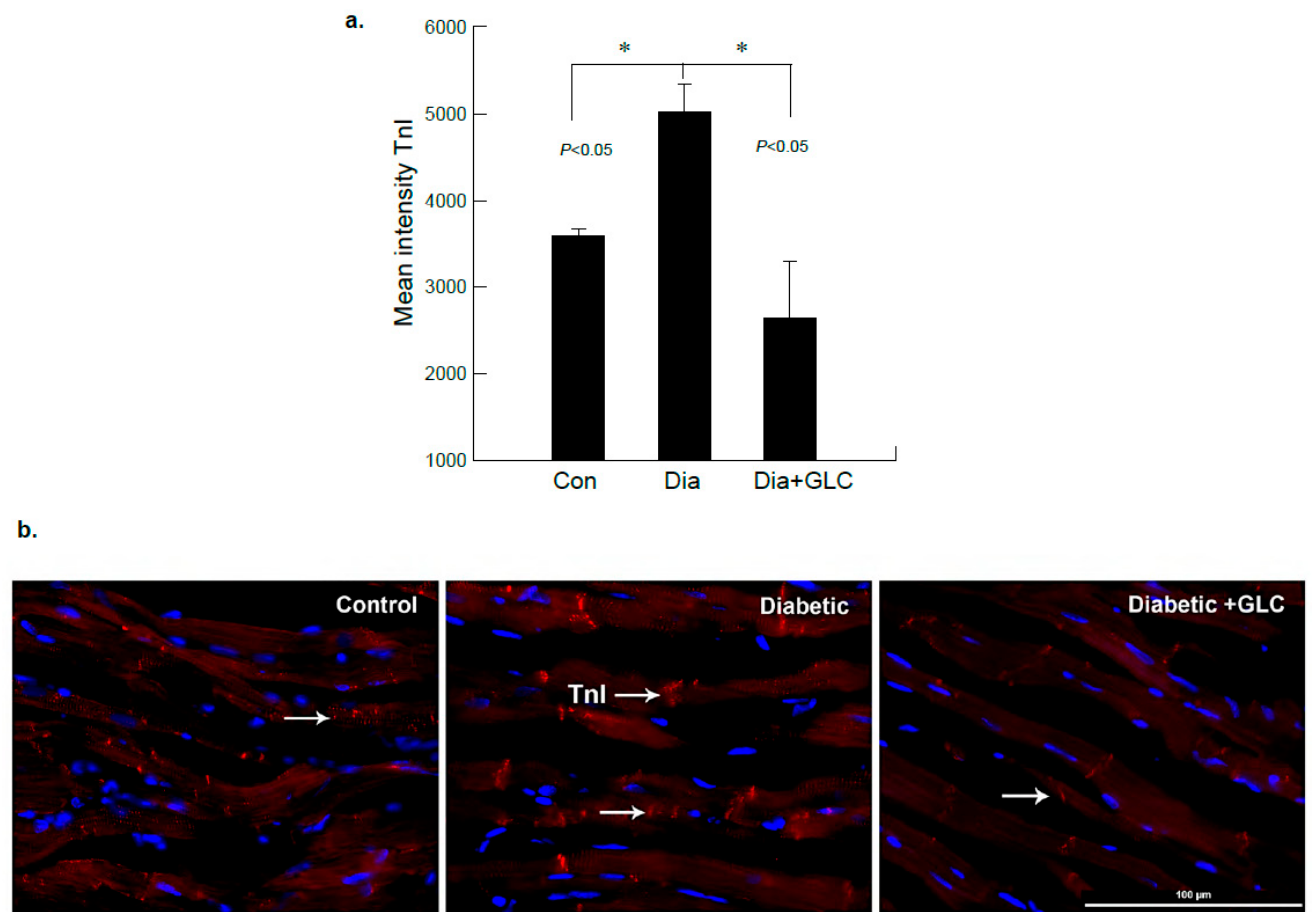
Figure 4. ZDF rats exhibited increased Troponin-I (TnI) expression in the cardiac tissue which was altered after GLC treatment. ( a ) Immunofluorescent images of heart tissues of lean control, ZDF diabetic and ZDF with GLC treated rats were analyzed, which showed noticeable changes in the intensity of TnI immunostaining in diabetic GLC treated rats after 4 weeks of treatment compared to ZDF diabetic rats (* p < 0.05). ( b ) ZDF diabetic rats demonstrated substantial increase in TnI expression compared to lean control rats as shown by representative images; arrows indicate TnI positive staining in red (Scale bar = 100 µm).